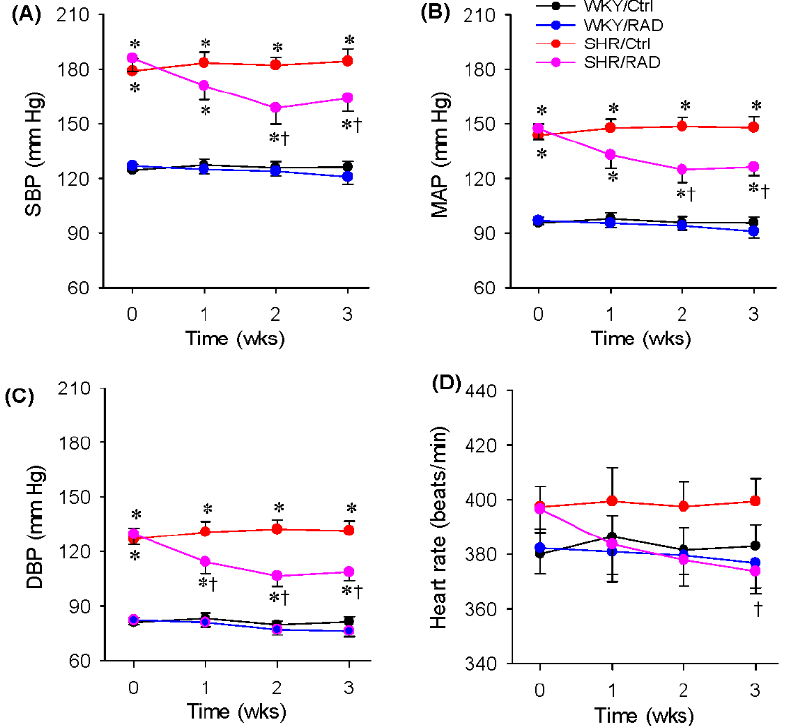
Figure 2. Effects of RAD on the blood pressure of the tail artery in WKY and SHR: ( A ) systolic blood pressure (SBP); ( B ) mean arterial pressure (MAP); ( C ) diastolic blood pressure (DBP); ( D ) heart rate. Values are mean ± SE. One-way ANOVA followed by Bonferroni’s post hoc analysis were used for comparisons. * p < 0.05 vs. WKY; † p < 0.05 vs. Ctrl. n = 6 for each group.